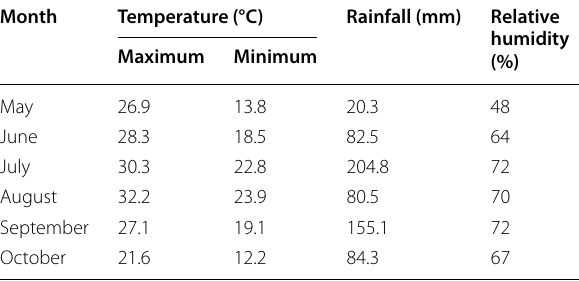
Table 2 Weather information during an experimental